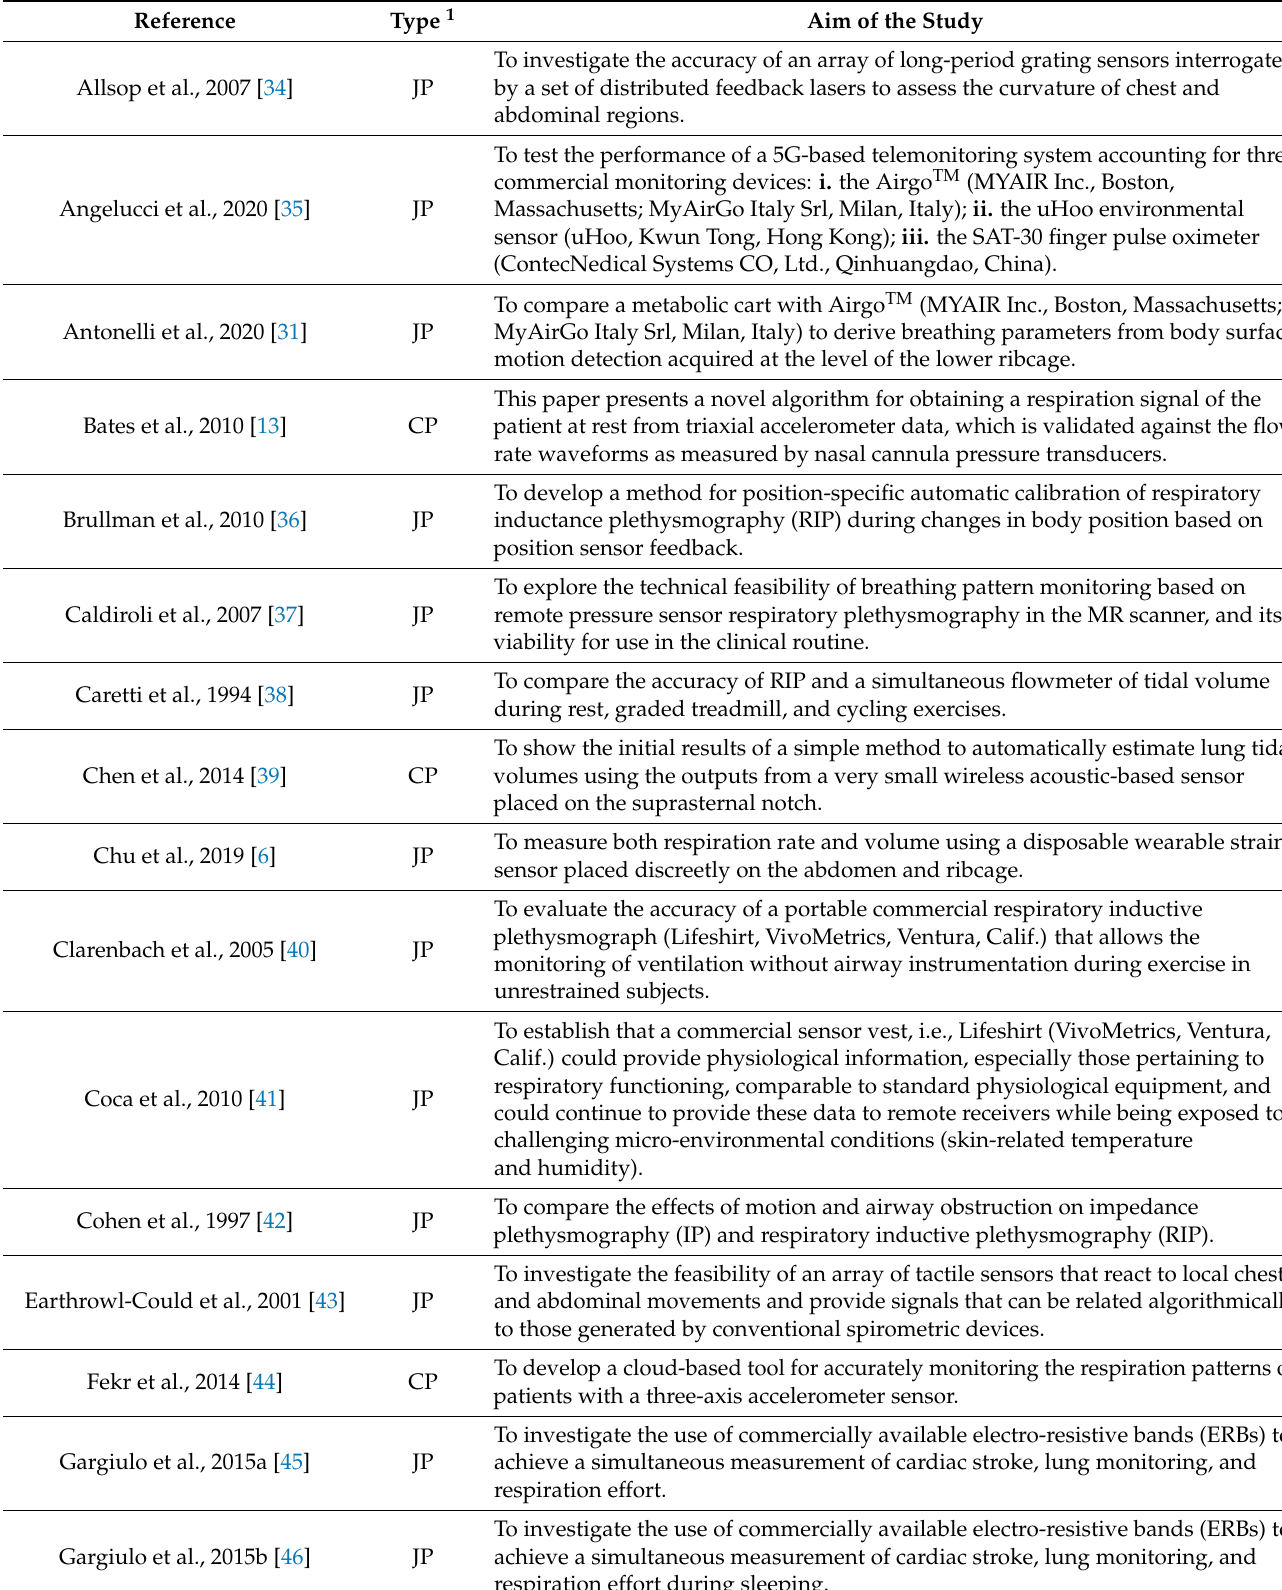
Table 1. Description of reviewed